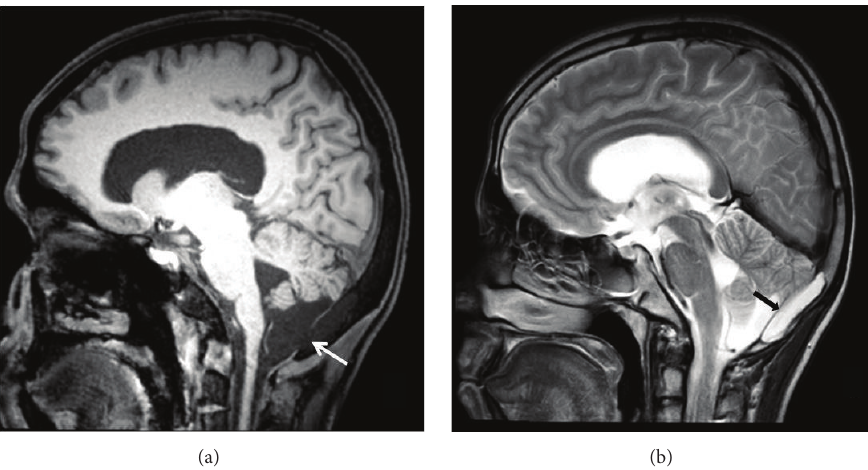
Figure 3: MRI brain (a) T1 sagittal and (b) T2 sagittal images showing intradiploic space expansion with CSF intensity lesion (black arrow) communicating with the cistern magna through a dural tear (white arrow).